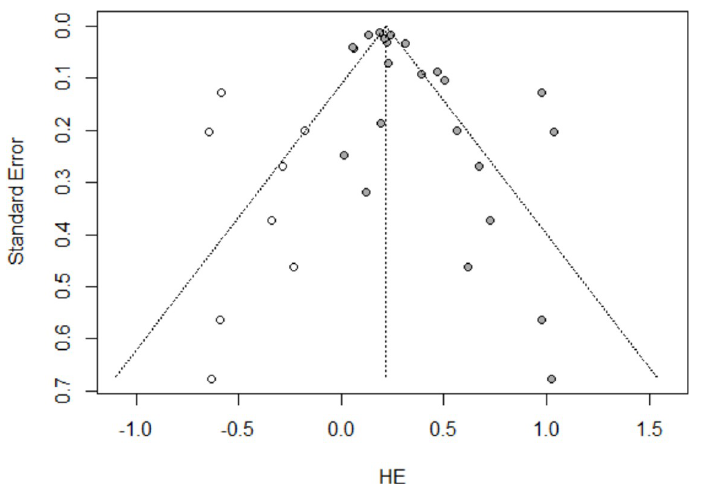
Fig 2. A funnel plot to confirm